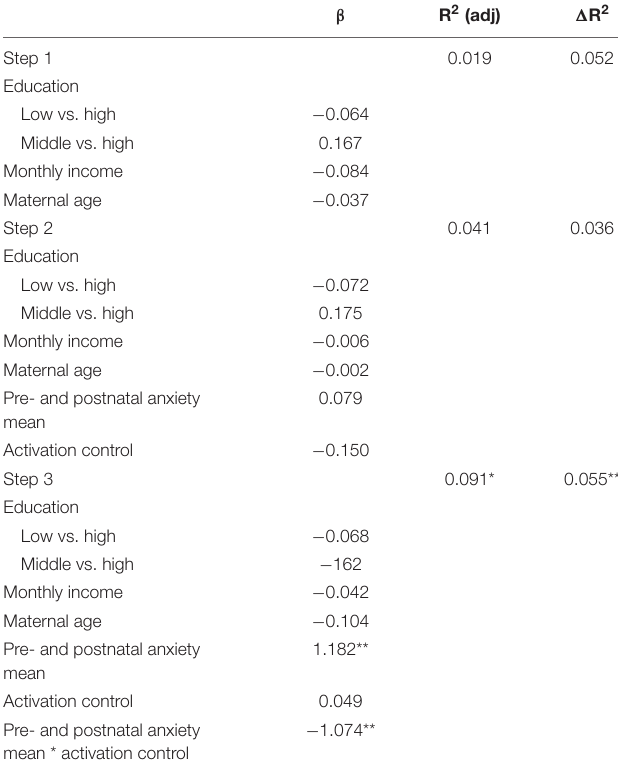
TABLE 7 | Standard linear regression model for the unpredictability of maternal sensory signals ( n =